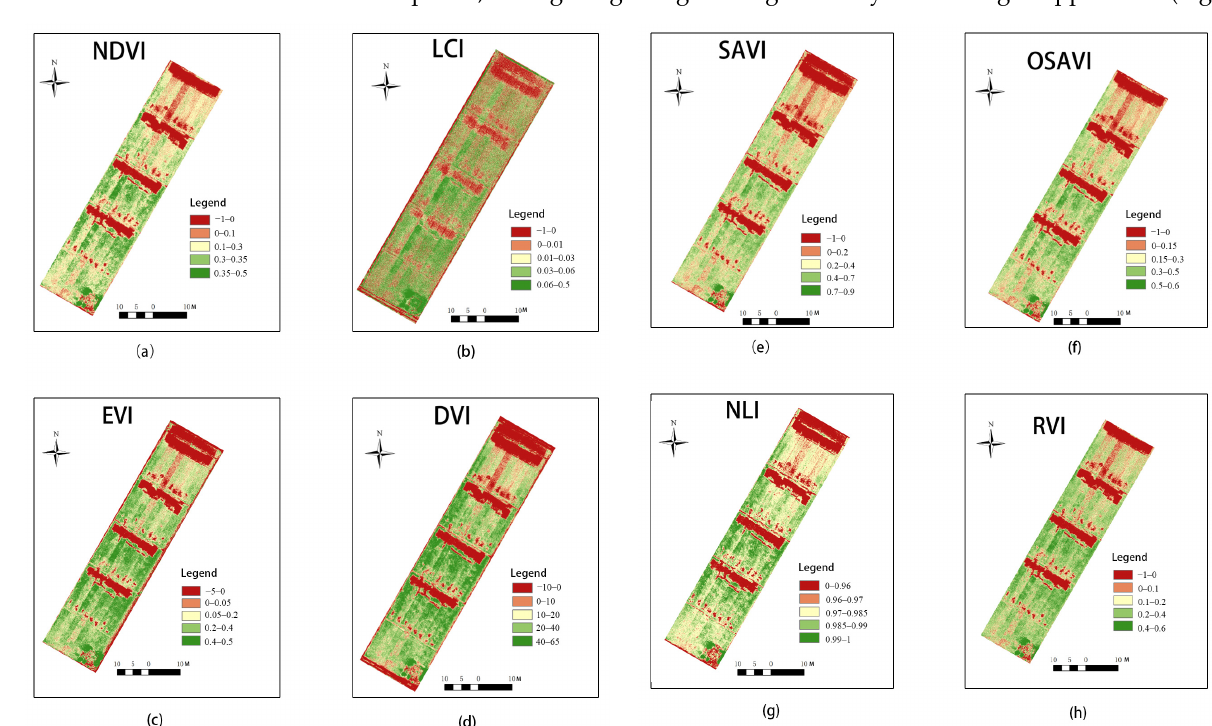
Figure 5. ( a – h ) shows the canopy vegetation index of peanut at full heading stage.